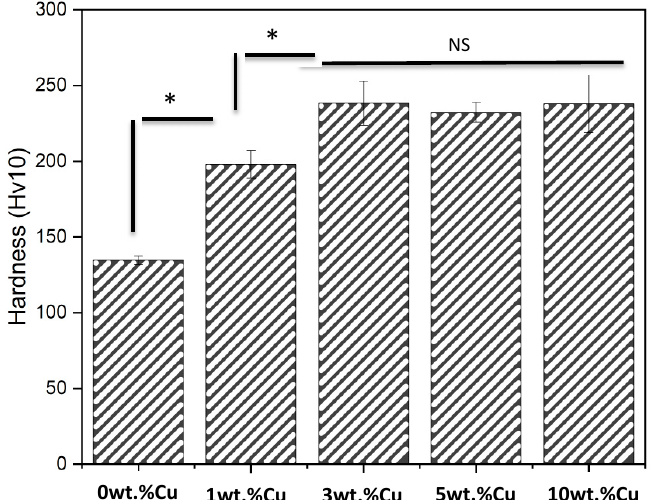
Figure 7. Vickers hardness of the TNTZ-Cu x alloys (“*” indicates statistical significance of p < 0.05, as per Tukey Anova test, while “NS” indicates no statistically significant difference).